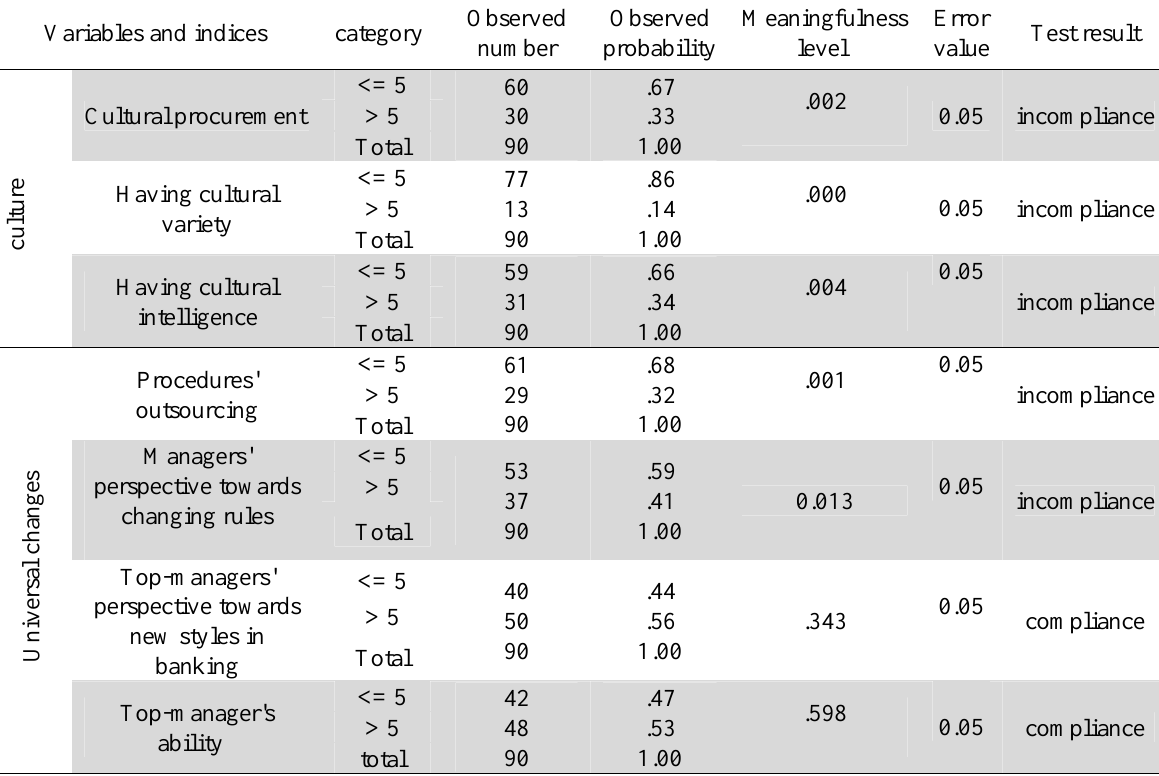
The infrastructure's variable proportion test